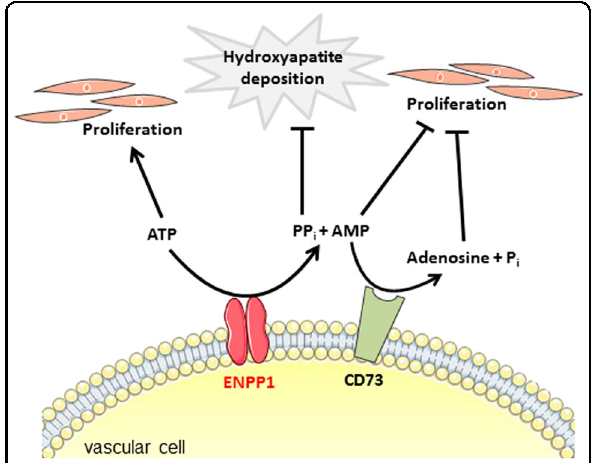
Fig. 6 The two roles of ENPP1: inhibiting arterial calci fi cation and myointimal proliferation by modulating extracellular PP i and ATP metabolism. The transmembrane ectoenzyme ENPP1 converts extracellular ATP to AMP and thereby generates PP i . AMP is further hydrolyzed by CD73 (5-exonucleotidase) to adenosine and P i . PP i is a physiologic inhibitor of hydroxyapatite formation, regulates chondrogenesis and is therefore important in the prevention of soft tissue calci fi cation. A decreased PP i /P i ratio leads to calci fi cation. Elevated extracellular ATP levels lead to increased VSMC proliferation, while AMP and adenosine are known to inhibit VSMC proliferation. In ENPP1 de fi ciency, independent of low PP i levels, proproliferating extracellular ATP levels increase, whereas antiproliferating AMP and adenosine levels decrease, leading to accelerated VSMC proliferation and arterial stenosis. We conclude that a decreased PP i /P i ratio leads to ectopic calci fi cation, whereas an increased extracellular ATP/AMP ratio leads to increased VSMC proliferation and arterial stenosis in ENPP1 de fi